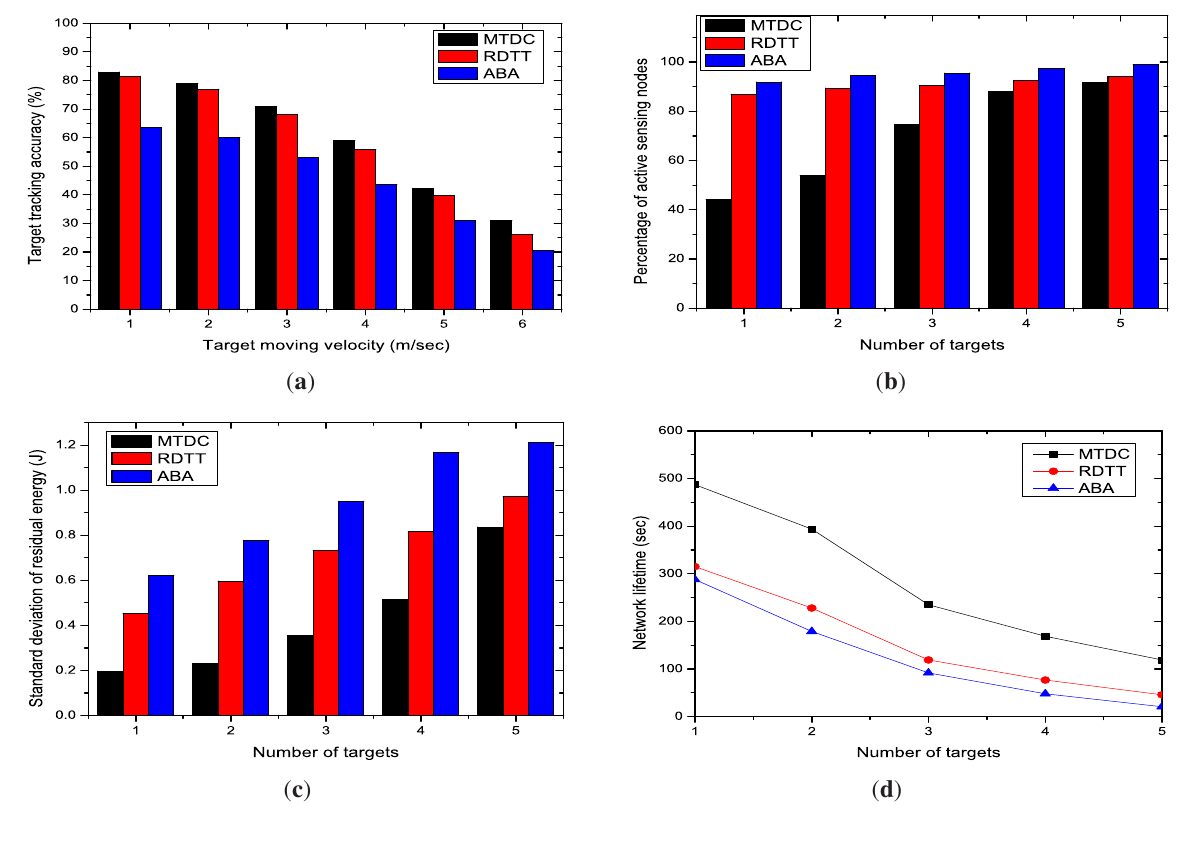
Figure 11. Impacts of the number of targets. ( a ) Target tracking accuracy; ( b ) percentage of active sensing nodes; ( c ) standard deviation of the residual energy; ( d ) network Lifetime.